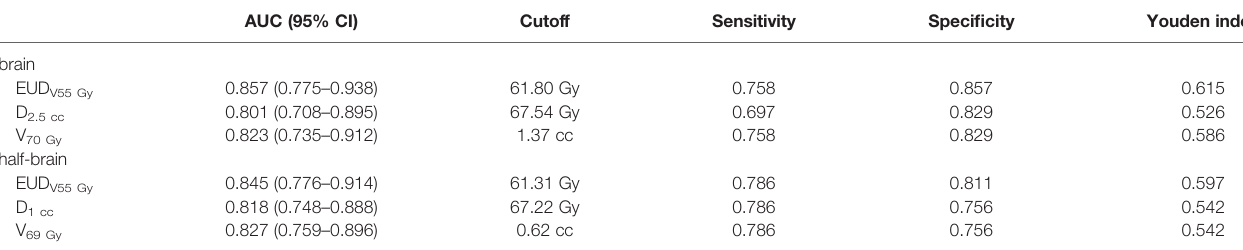
TABLE 3 | Comparison of dosimetric parameters for brain injury prediction.